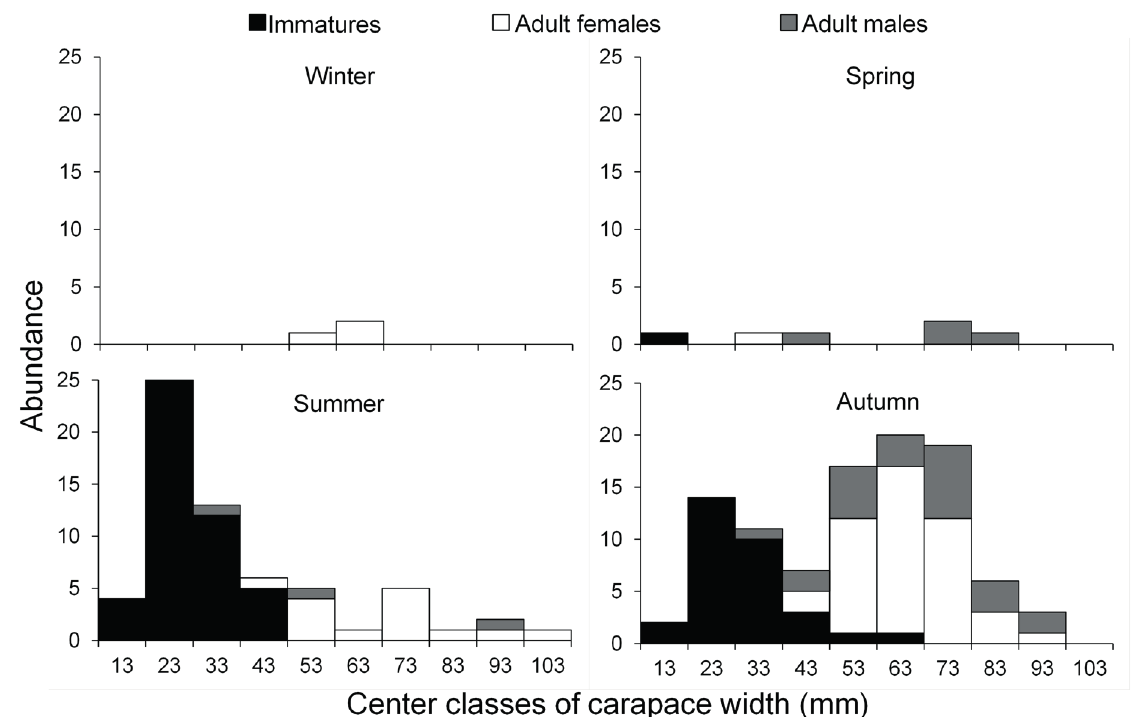
Figure 4 . Size-frequency distribution for demographic groups and recruitment period of the swimming crab Achelous spinimanus collected off Macaé, an upwelling region on the southeastern Brazilian coast. Intervals of 10 mm size class were used, ranging from 8 | ― 18 mm (class 1) to 98 | ― 108 mm (class